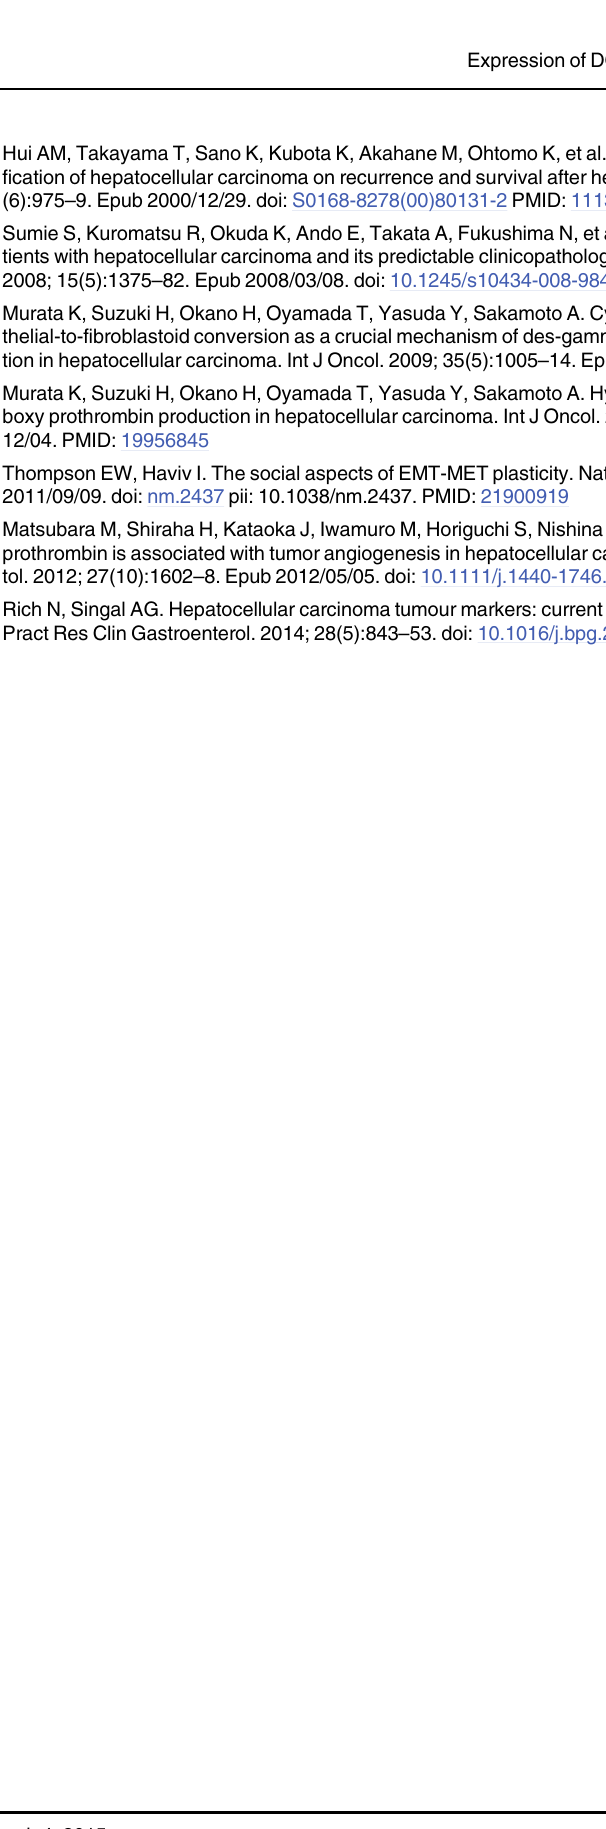
PLOS ONE | DOI:10.1371/journal.pone.0118452 March 4,